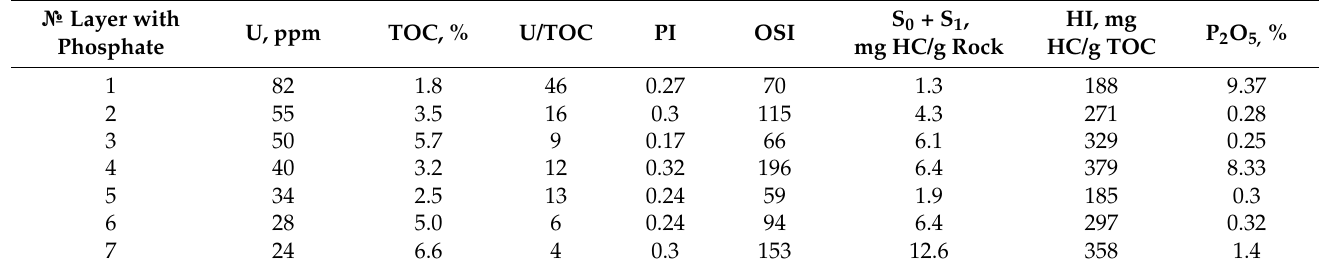
Table 1. Pyrolysis parameters, the concentration of uranium and phosphates (P 2 O 5 ) for the intervals with high uranium content and low organic matter content (Figure 10).